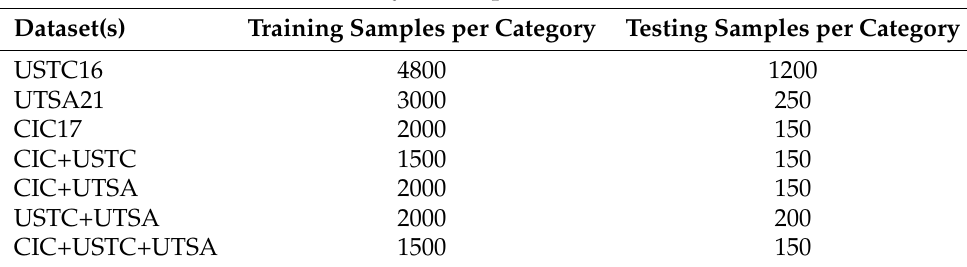
Table 2. The number of training and testing samples taken from each category in each dataset during each separate instance of analysis. Because the benign category of CIC17 contains mixed traffic, we take more from that benign category in all analyses. Specifically, we take 15,000 benign CIC17 samples for training, and 1500 for testing. Additionally, because of the imbalance in the number of benign and malicious categories in the UTSA21 dataset, we take twice as many benign samples for its individual